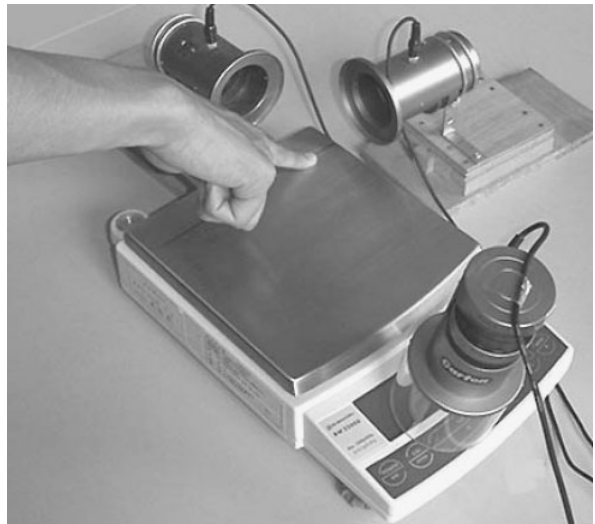
Figure 1 Three CCD cameras were installed around the platform of an electric scale to record finger images with two cameras and the liquid crystal monitor of the electric